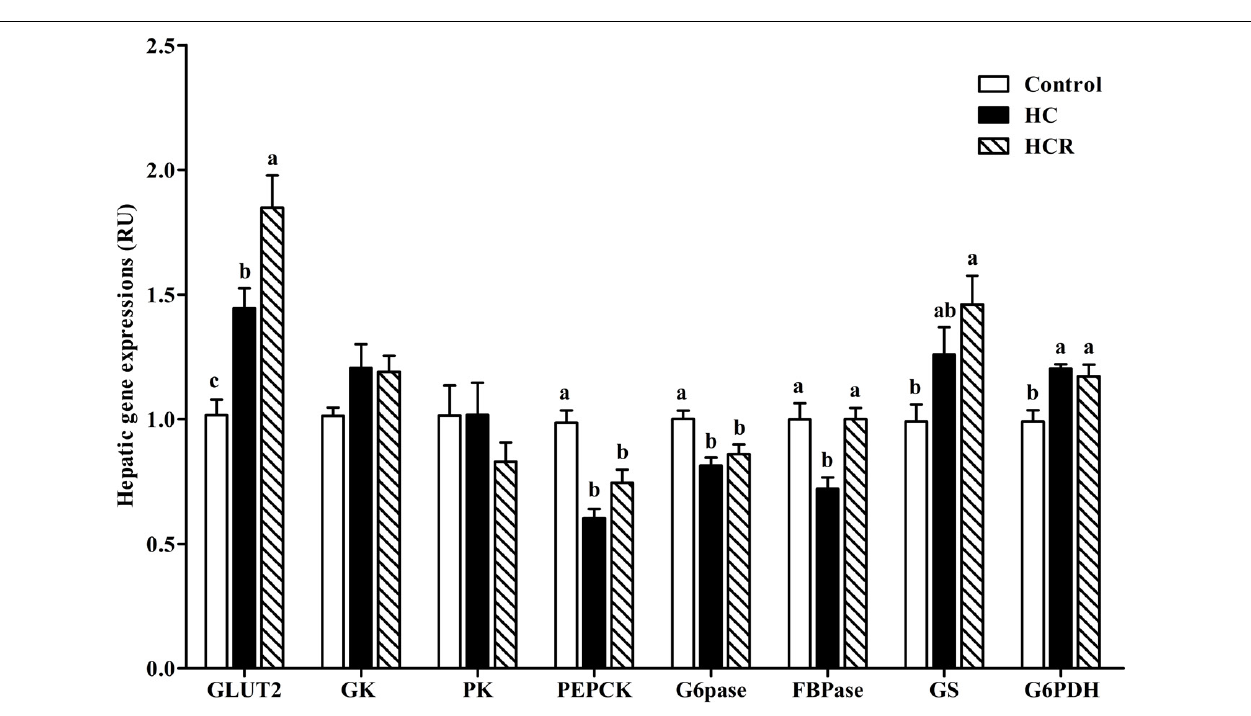
FIGURE 4 | Relative expressions of the genes involved in glucose metabolism in the liver of blunt snout bream fed different experimental diets. Data are referred to the values (relative units, RU) obtained in fish fed the control diet. Values were normalized with the transcription of EF1 α . Each data represents the mean of four replicates. Bars assigned with different letters are significantly different ( P < 0.05). Control, diet with 30% carbohydrate level; HC, diet with 41% carbohydrate level; HCR, diet with 41% carbohydrate and 0.04%